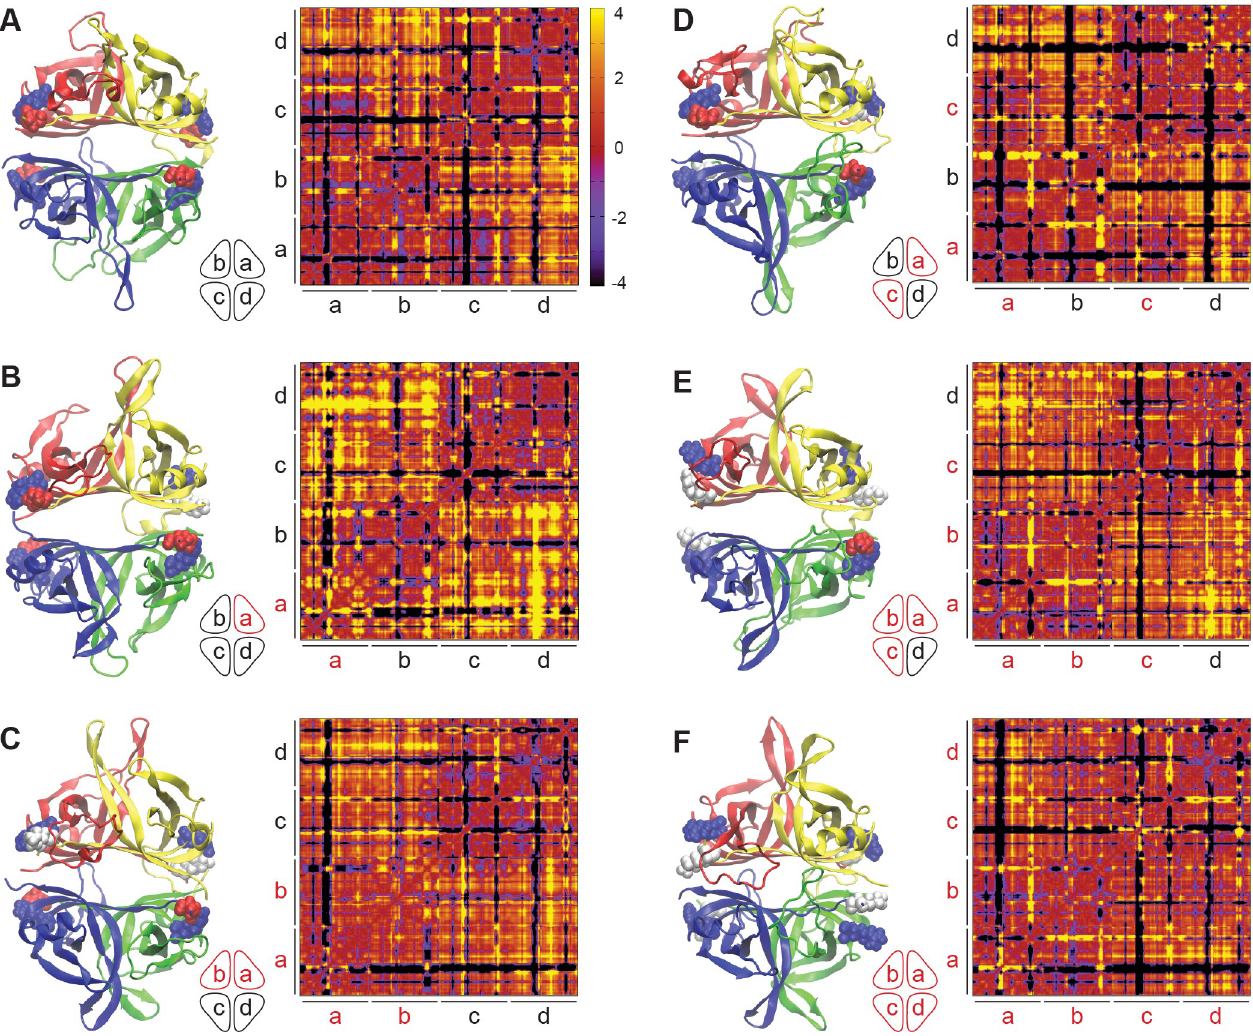
Fig 7. Tetramer stability is illustrated by snapshots of the representative conformations obtained from the latter part of each molecular dynamics trajectory. The six configurations simulated are shown ( A-F ). Each monomer is color-coded (a, yellow; b, red; c, blue; d, green) and E27 is shown in red solid spheres with its salt bridge residue R38 (in blue). The mutant residues (K27) are shown in white spheres. Heat maps of deviations of C α distances calculated from the last 100 ns of each trajectory are shown next to each structure. Mutant monomers are indicated in red in the cartoons and the axis labels. Large negative and positive C α deviations are displayed in black (closer in space) and yellow (farther in space), respectively.